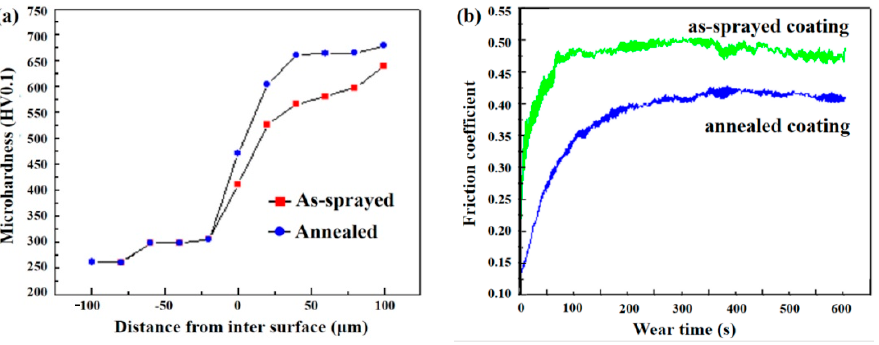
Figure 7. ( a ) Hardness and ( b ) friction coefficient of plasma sprayed NiCrBSi coating and post heat-treated NiCrBSi coating.